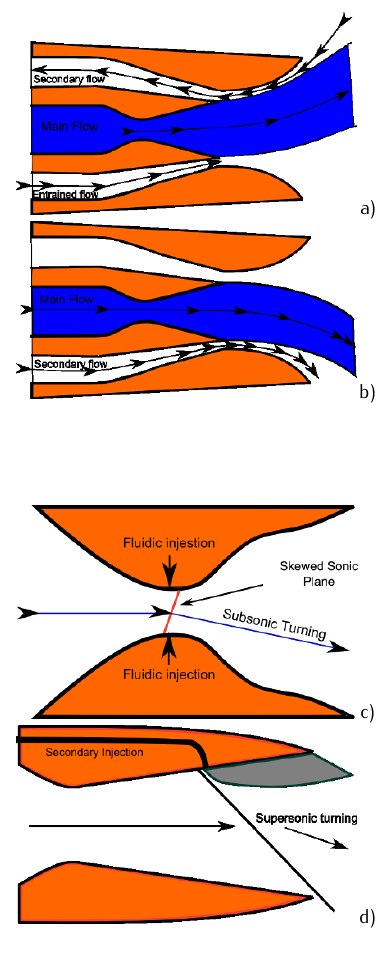
Figure 4. Fluidic vector thruster control. a) Counter flow nozzle. b) Co-flow nozzle. c) Throat shifting nozzle. d) Shock vector